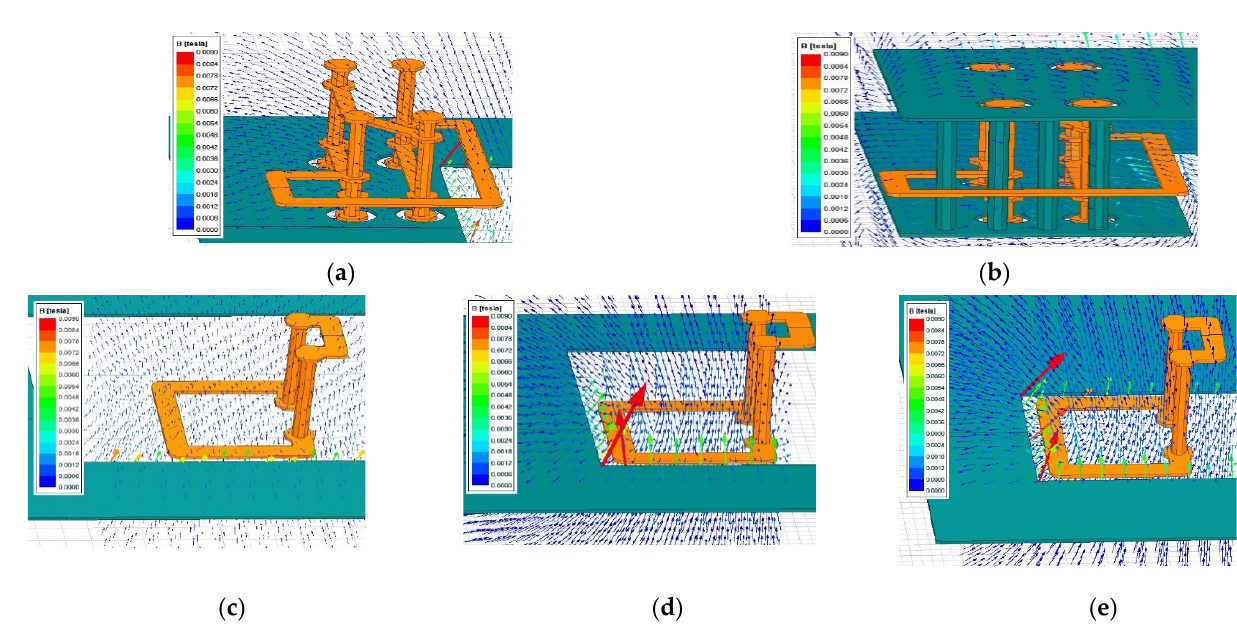
Figure 4. Magnetic field flux density at 5-A conductor current with finite element method (FEM). ( a ) Model-A, ( b ) Model-B, ( c ) Model-C, ( d ) Model-D, and ( e ) Model-E.